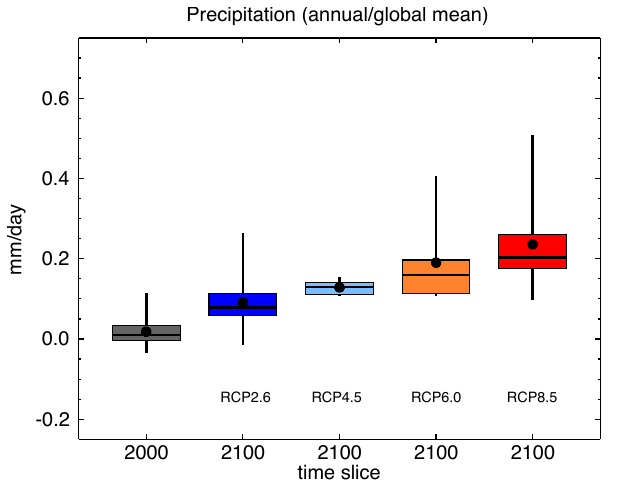
Fig. 9. Same as Fig. 8 but for 700 hPa temperature change since 1850.